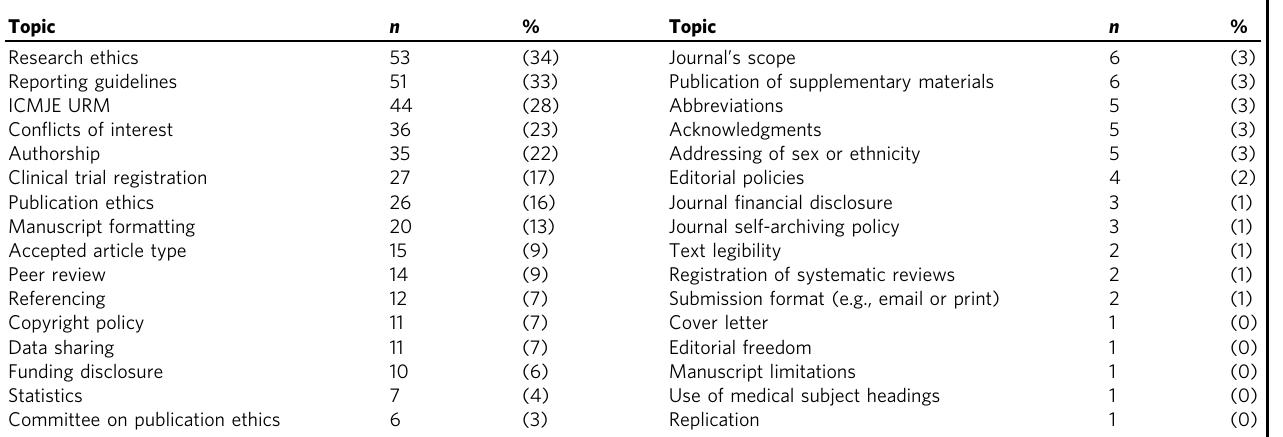
Fig. 2 Growth of the number of publications analysing journals ’ Instructions to Authors (ItAs). Growth of ItA studies is shown alongside that of journal articles in Crossref, PubMed, Scopus, and Web of Science. Prediction lines were determined by optimal spline regression models. Table 2 Number of publications analysing a speci fi c topic in journals ’ Instructions to Authors ( N =